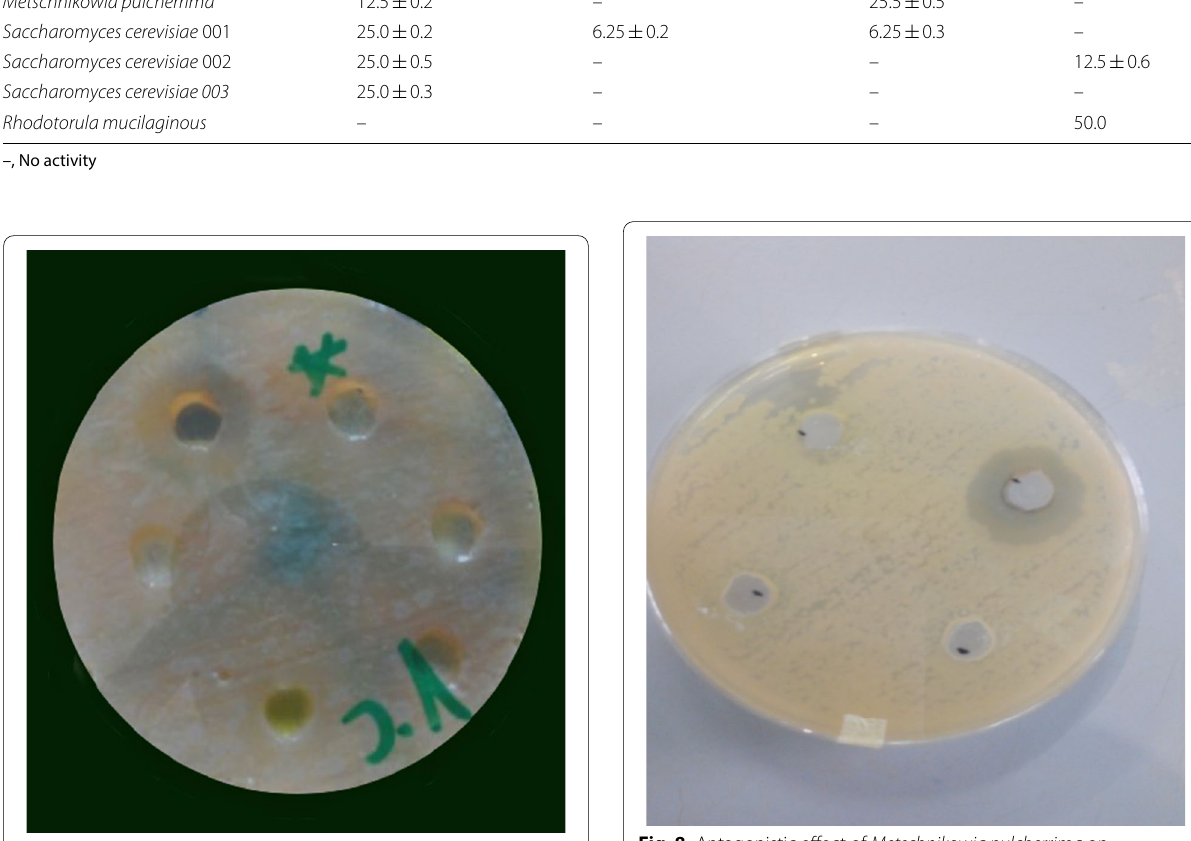
Fig. 6 Inhibition of Kluyveromyces phaffii on Vibrio cholerae